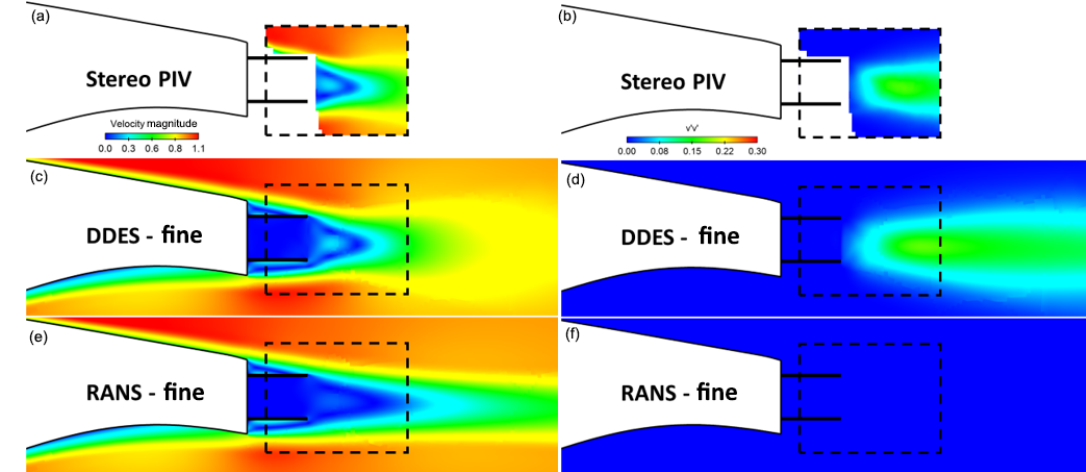
Figure 10. Offset cavity case. Normalised velocity magnitude contours, V/V ∞ , (a, c, e) and v (cid:48) v (cid:48) /V 2 ∞ normal Reynolds stress contours (b, d, f) : comparison between stereo PIV, RANS and IDDES results. The fine mesh (25 million cells) was used in the